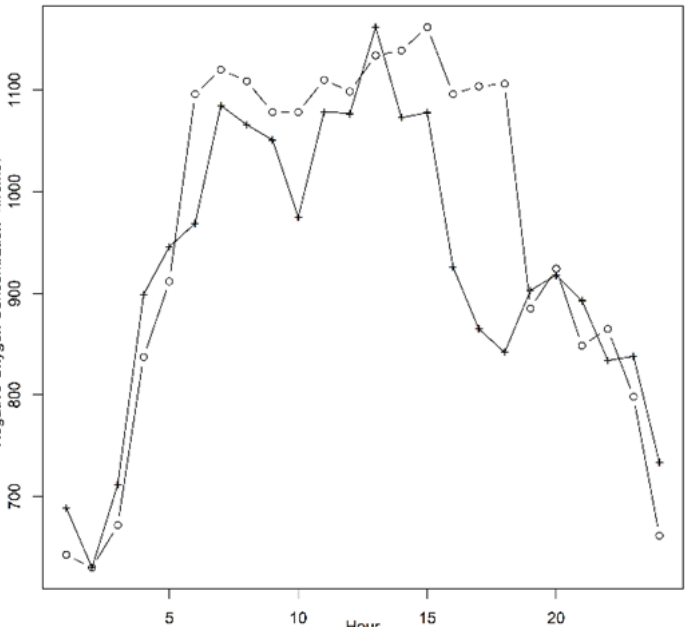
Figure 14. Negative oxygen ion concentration test (‘ ○ ’ is measured by this equipment and ‘+’ is measured by COM-3500A).